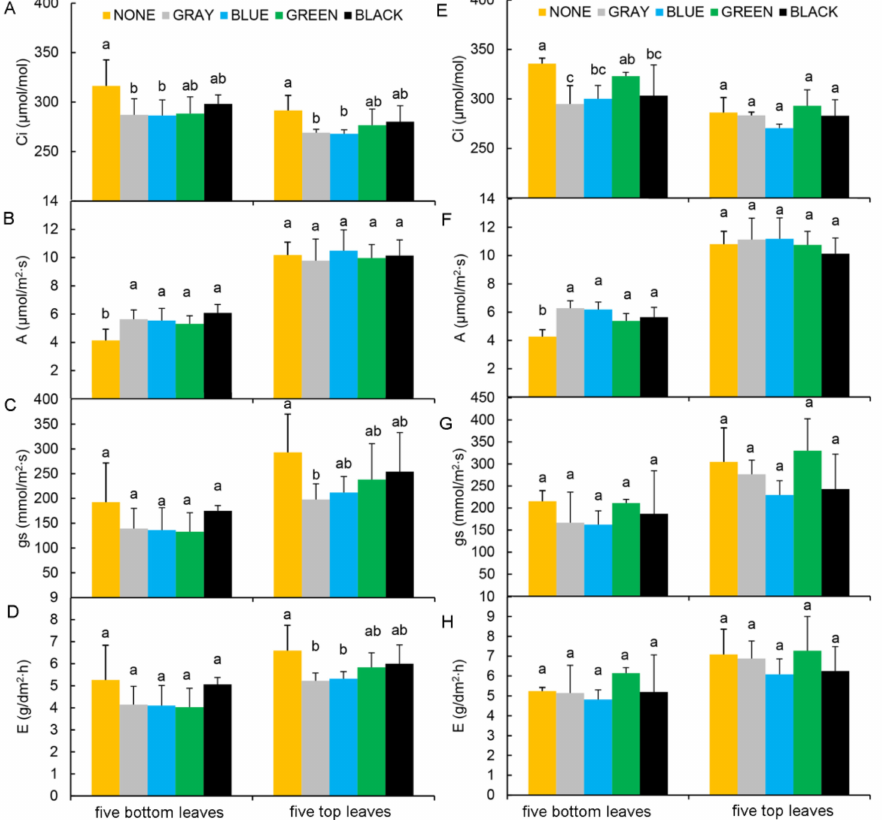
Figure 4. Differences in the photosynthesis-related parameters of the grapevine leaves across the different treatments. Ci , A , gs , and E across the different treatments at PQ ( A – D ) and ZH ( E – H ). NONE, no shading; GRAY, BLUE, GREEN, and BLACK, shade net colors. Different lowercase letters indicate significant differences ( p <